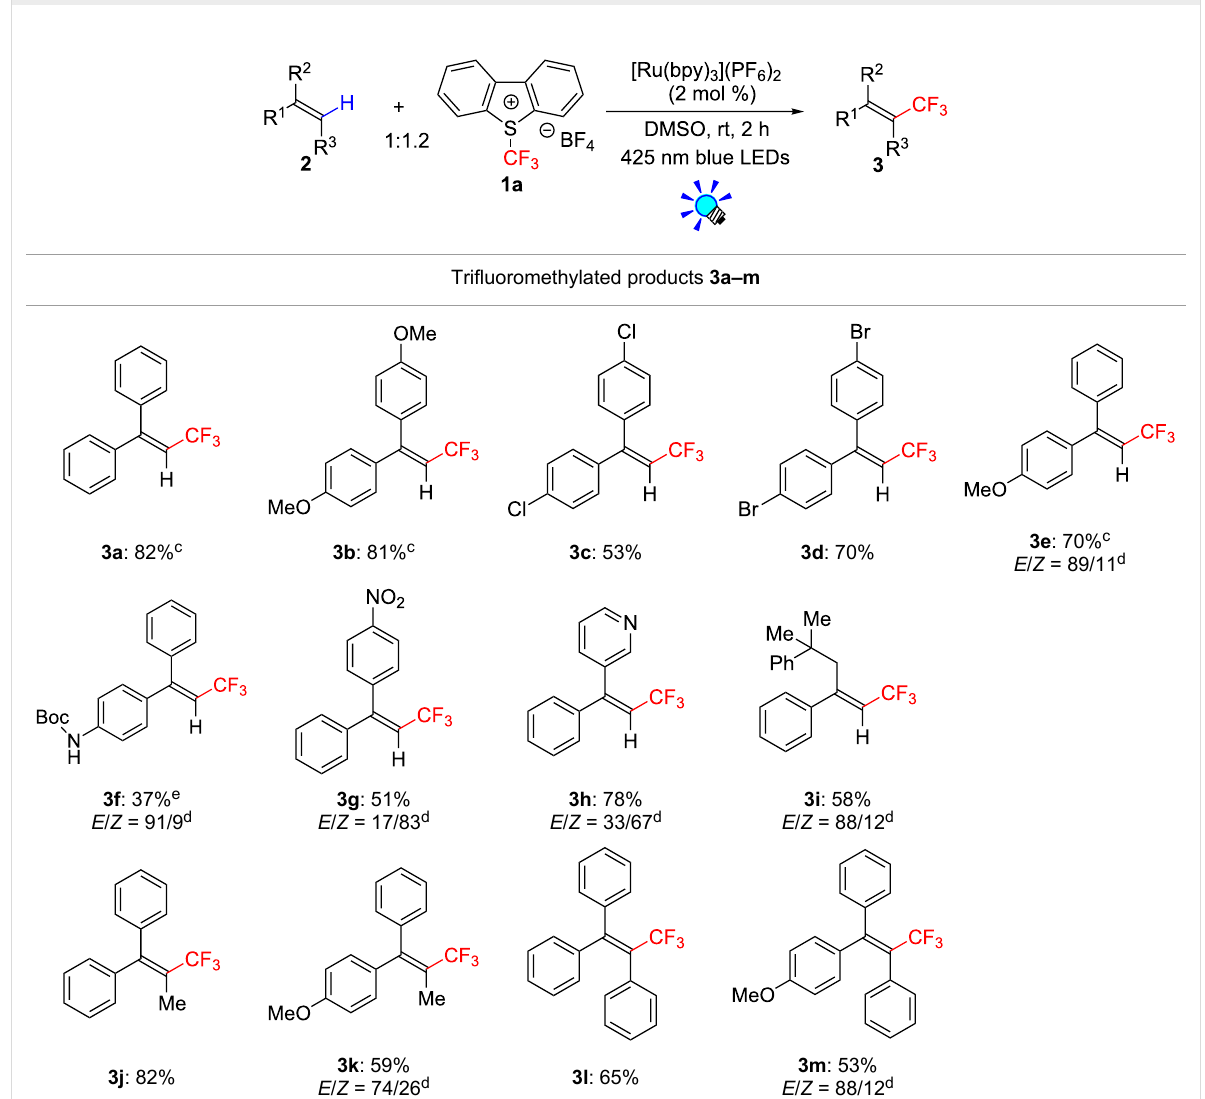
Table 2: The scope of the present trifluoromethylation of alkenes. a,